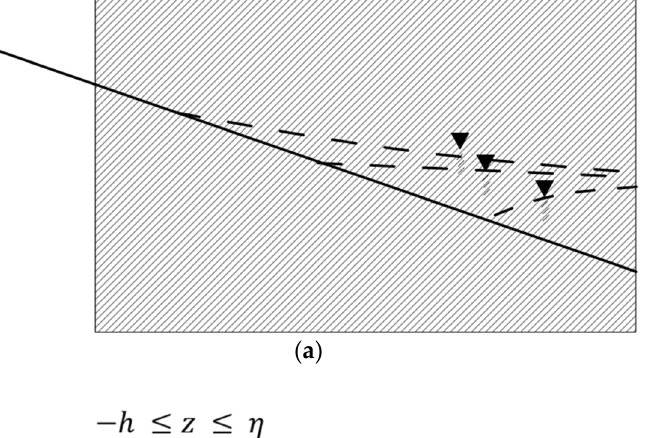
( b ) Figure 2. Description of the two coordinates: ( a ) three-dimensional view; ( b ) 𝑥 − 𝑧 section. The governing equation of an edge wave is the Laplace equation derived from the fluid mass conservation. ∇ (cid:2870) 𝜙 (cid:3046) = 0